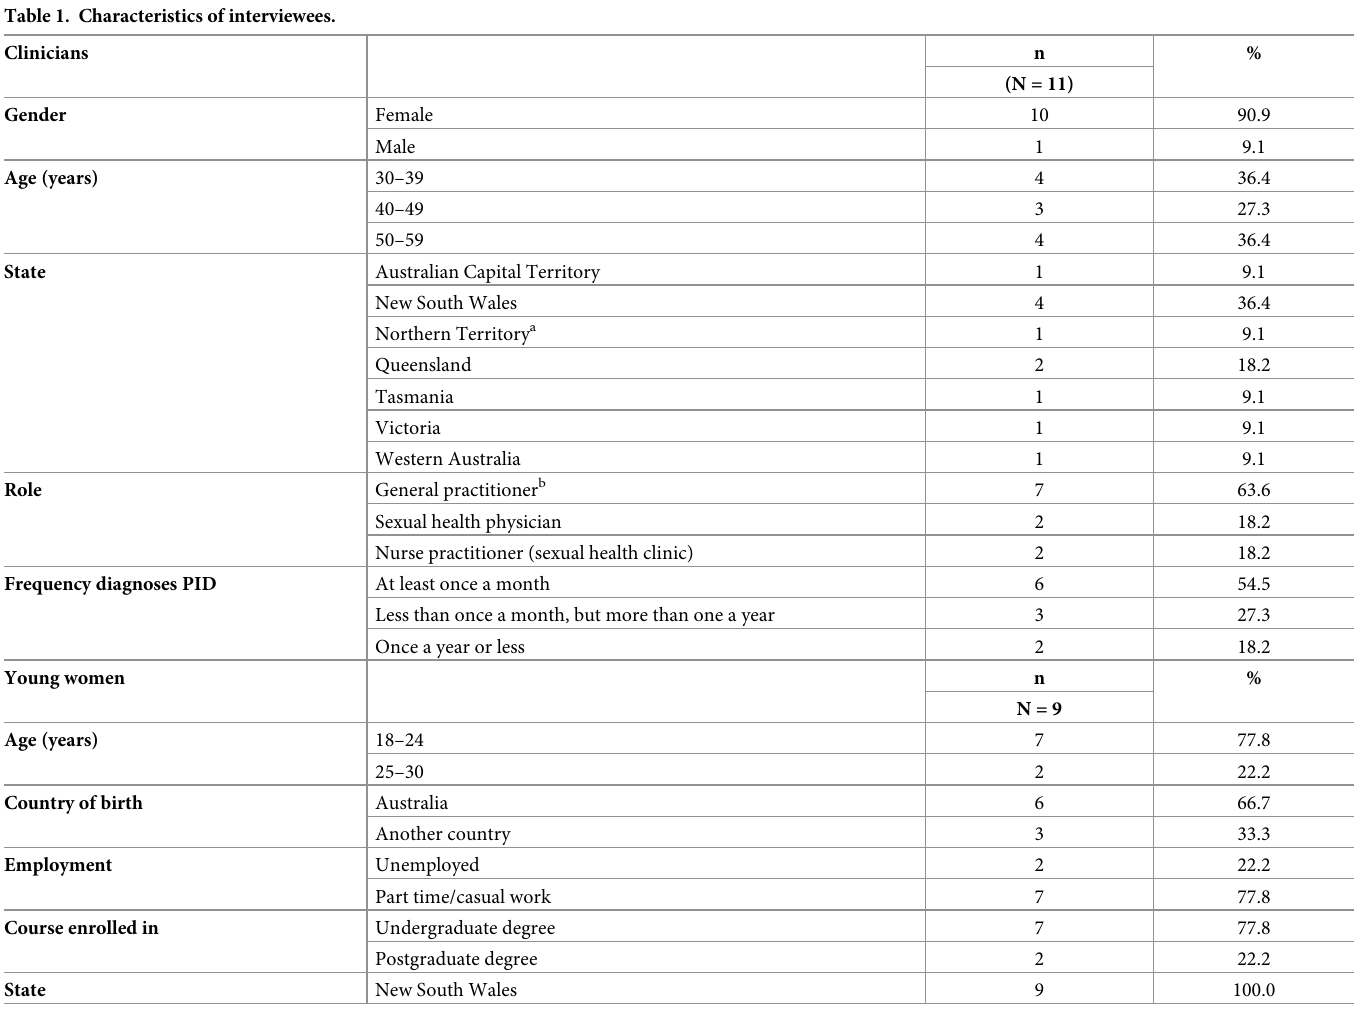
Table 1. Characteristics of